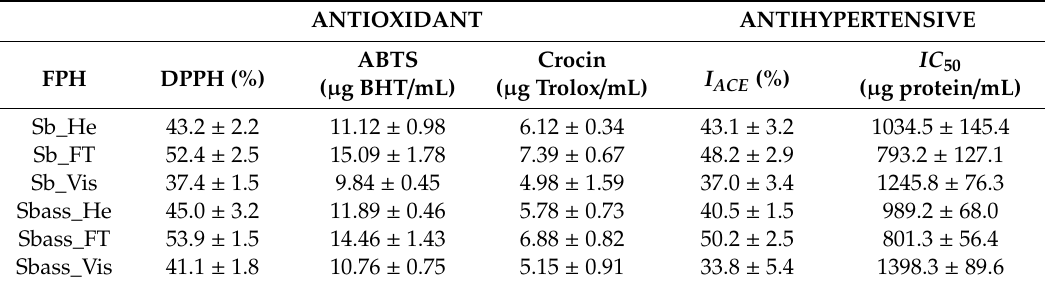
Table 6. In vitro antioxidant and antihypertensive activities of FPH from Sb and Sbass waste. Mean ± confidence intervals for n = 2 (samples from independent hydrolysates) and α = 0.05. I ACE : inhibitory activity of angiotensin I converting enzyme (ACE) and IC 50 : half maximal inhibitory concentration.